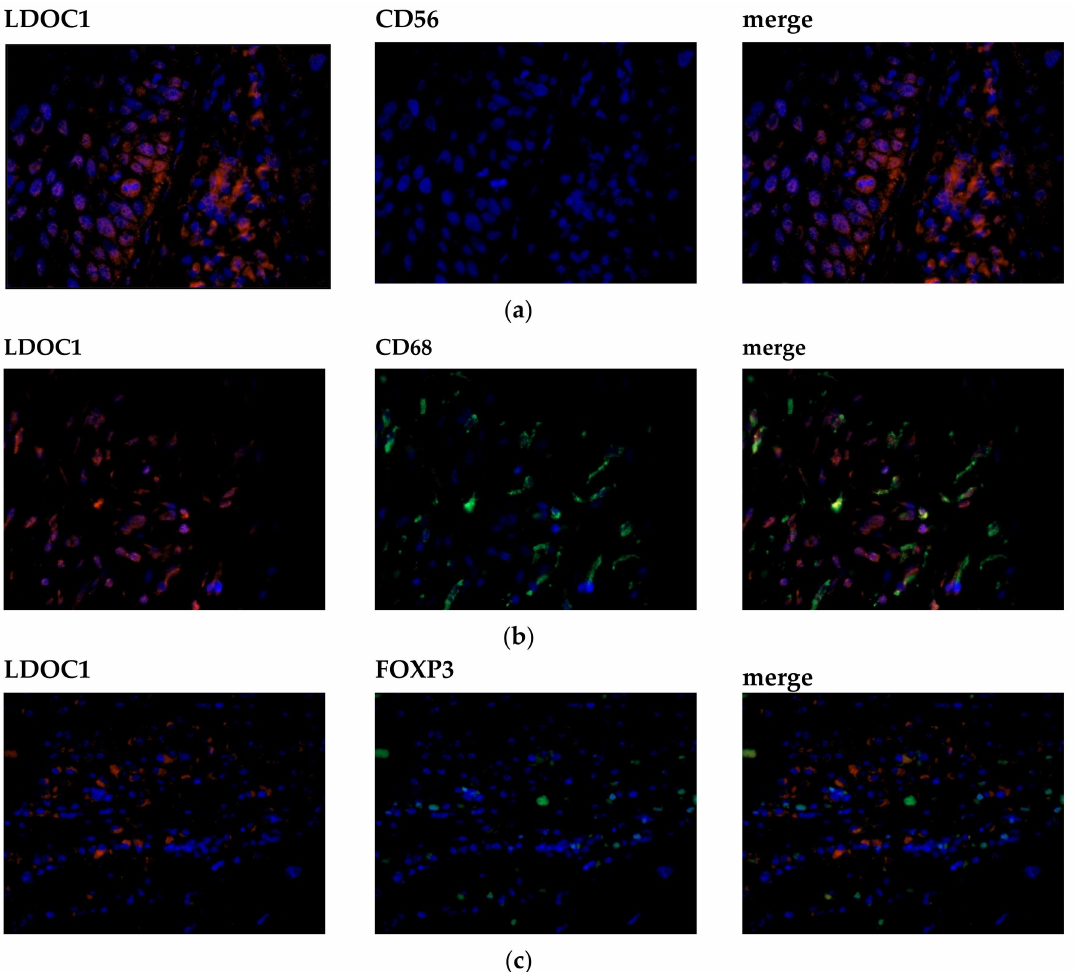
Figure 4. Characterization of the immune cell subpopulation by immunofluorescence double staining. Cell nuclei were marked by DAPI staining (blue). Left column showing LDOC1-positive cells (red), center column showing positive immune cells (green), right column showing a co-expression of the evaluated immune cell marker (green) and LDOC1 (red). Most infiltrating cells were CD68-positive macrophages, followed by FOXP3-positive regulatory T-cells. Representative photomicrographs are presented (40x magnification): ( a ) no expression of CD56-positive immune cells; ( b ) for CD68-positive immune cells (green) a co-expression of LDOC1 (red) could be detected; ( c ) for FOXP3-positive immune cells (green) a co-expression of LDOC1 (red) could be